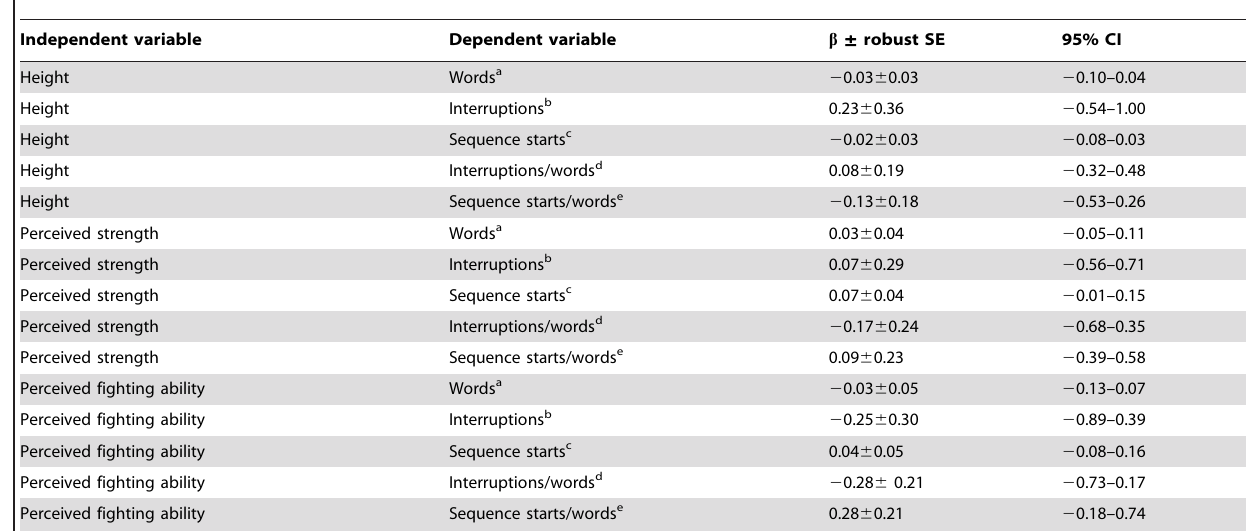
Table 2. Linear regressions of conversational dominance variables on standardized male formidability variables.